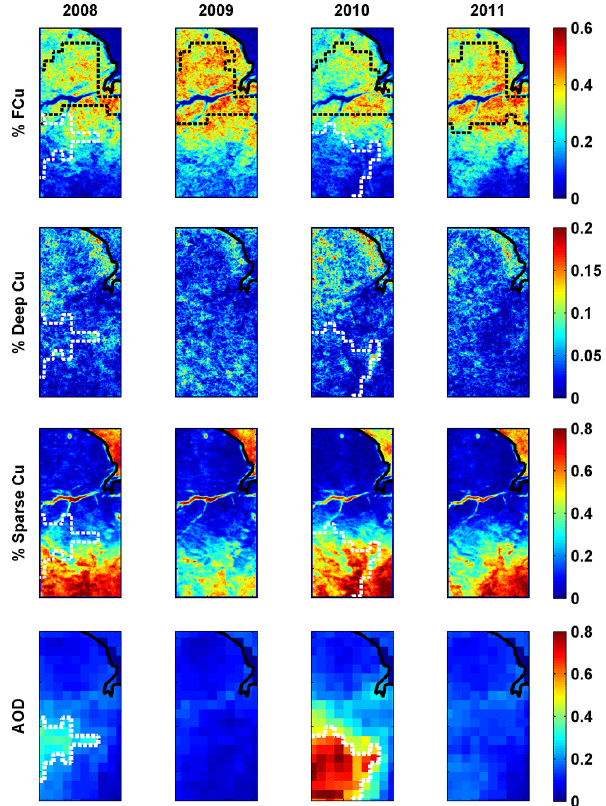
Figure 6. Cloud field statistics and AOD during J-A-S for 2008 (left panels) to 2011 (right panels). Panels include (from top to bottom) chance for FCu field, chance for deep convective cumulus field, chance for sparse to no cumulus field, and mean AOD taken from the Giovanni online data system. White dashed contours in 2008 (2010) panels indicate the region of AOD > 0.25 (0.5). Black dashed contours in upper panels represent areas with minimized me- teorological variance (see Sect. 3.1), for each year, used in Sect. 3.3 for EVI vs. pFCu analyses. High-AOD pixels along the mouth of the Amazon River were discarded as they correspond to a MODIS AOD algorithm artifact in that area due to the sediment-laden waters